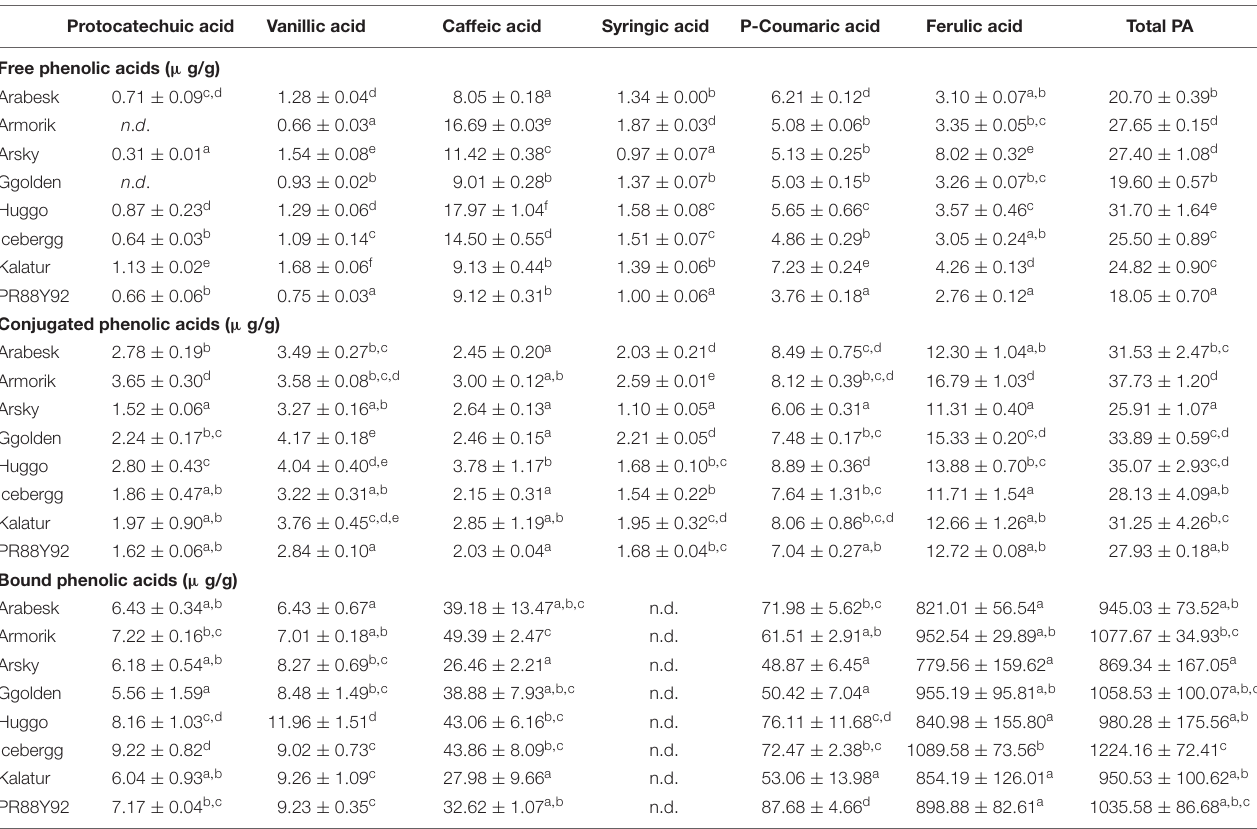
TABLE 5 | Content of free, conjugated, and bound PA in the eight varieties of sorghum calculated from the peak areas of the high-performance liquid chromatography (HPLC)